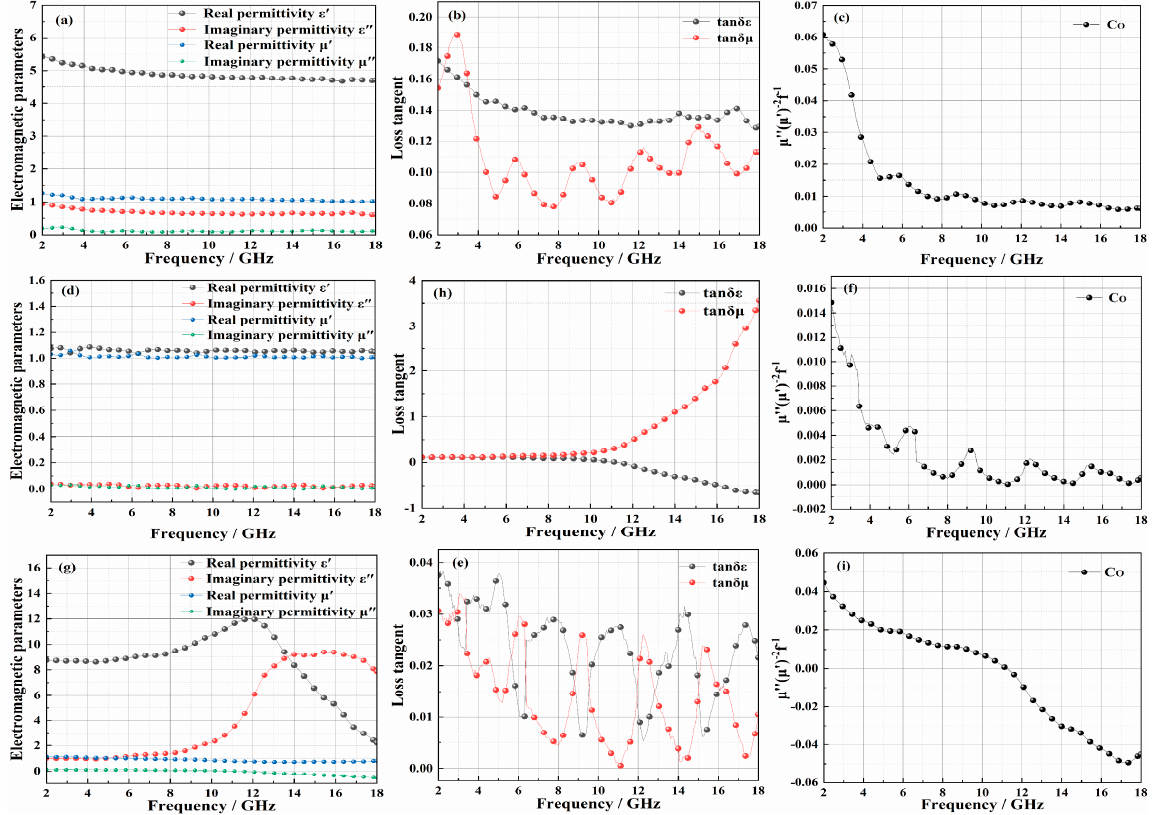
Figure 5. ( a – c ) EM parameters of matching layer and EM-absorbing layer; ( d – f ) EM parameters of rigid polyurethane foam; ( g – i ) EM parameters of the reflective